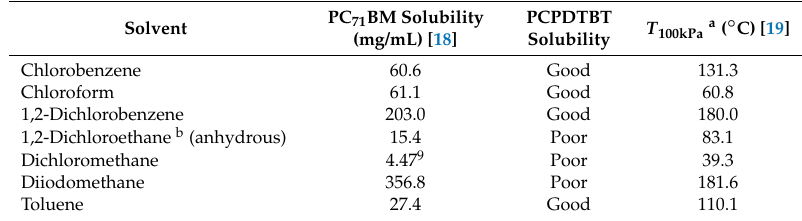
Table 1. Possible PC 71 BM solvents for the fabrication of the polymer/fullerene heterojunction.